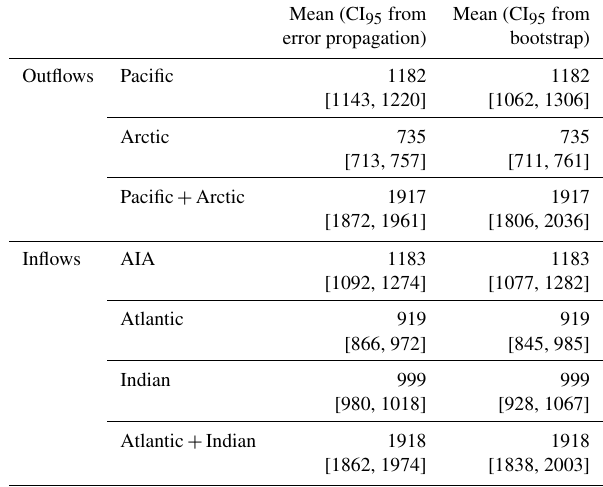
Table 3. Mean of the N component as estimated from the JPL mas- con solution for different ocean basins according to Eq. (2). CI 95 values are estimated as the propagation of mascon errors provided by JPL and from bootstrap analysis. Units are gigatonnes per